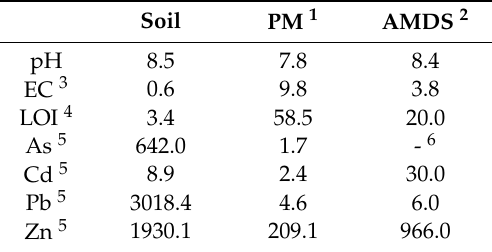
Table 1. chemical characteristics and total trace elements concentrations of the soil and amendments ( n = 3).